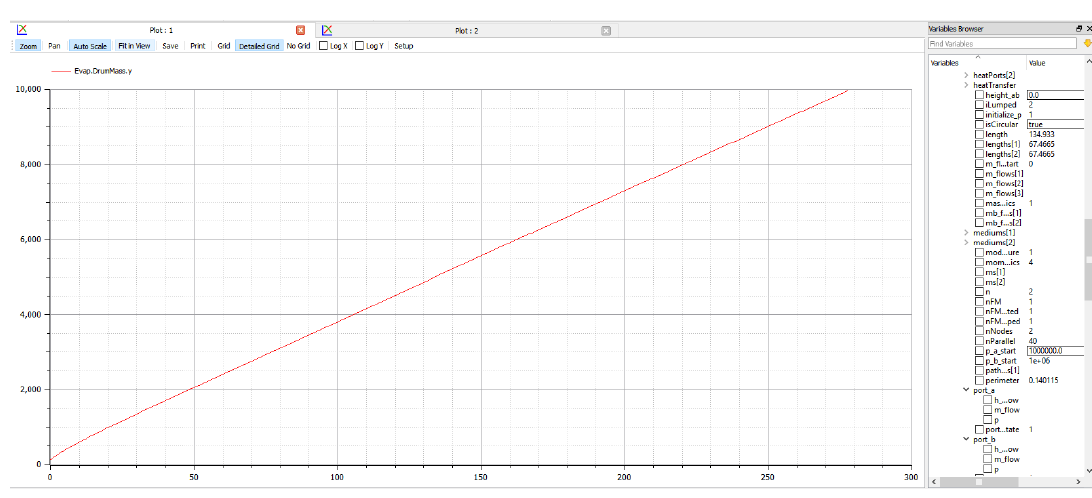
Figure 9: Plot of drum mass at blocked drum